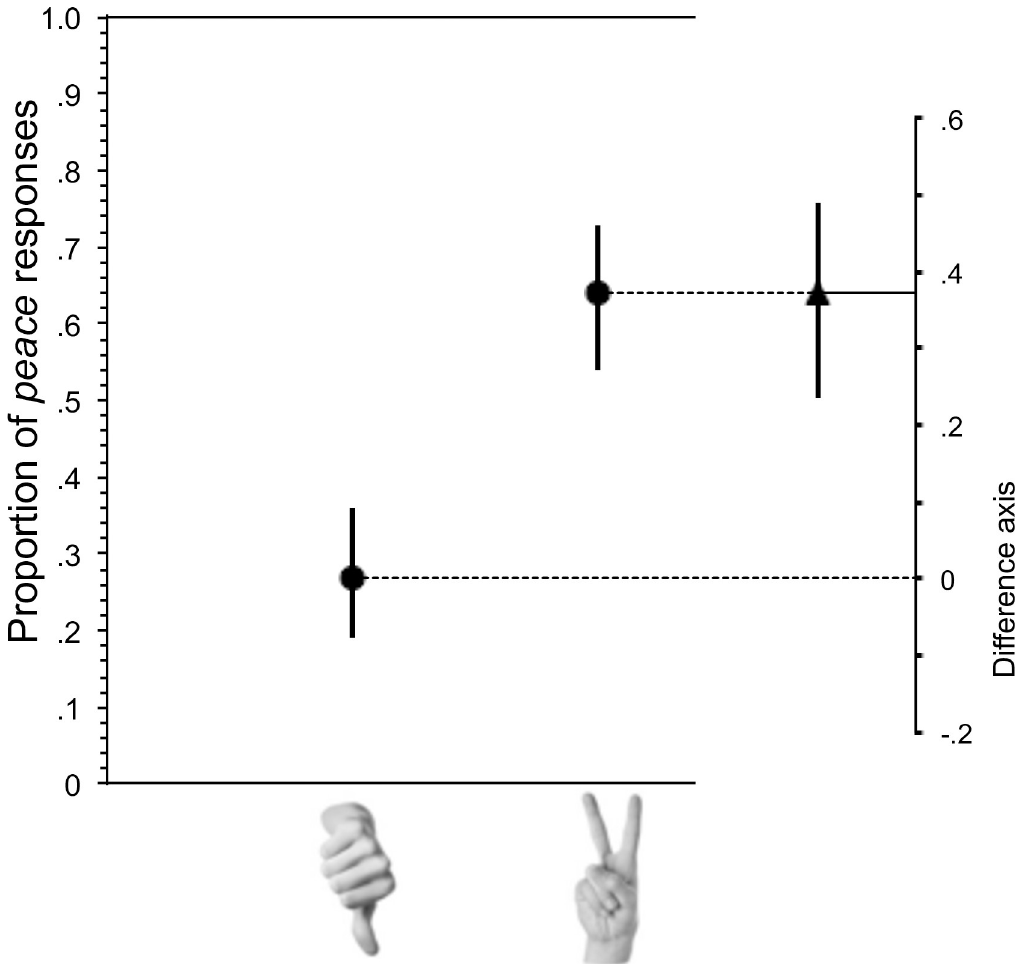
Fig 2. Effect of preceding gesture on completion of word completion prompt: p e a _ _. The proportion of peace completions of the p e a _ _ stem was significantly higher following the Peace gesture than the Thumbs-Down gesture. Whiskers indicate 95% confidence intervals. The difference between the group values, with its 95% confidence interval, is shown on a floating difference axis at the right.